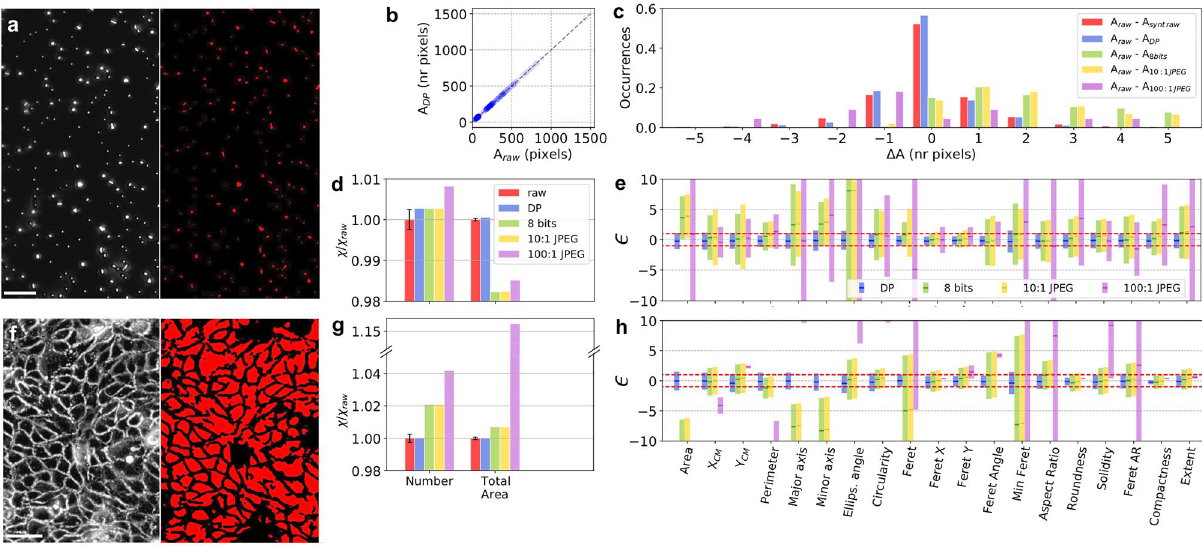
Figure 2. Statistical distortions induced by compression in 2D segmentation tasks in PC microscopy. ( a ) Micrograph of microspheres (scale bar: 20 μm) with corresponding segmentation mask. ( b ) Area of each segmented object obtained from the raw (A raw ) and the corresponding 6.7:1 DP compressed image (A DP ) for all objects. c Histogram of the difference in the single object area (∆A) determined from the raw and the statistically raw-equivalent images (A raw –A synt raw ), the DP (A raw –A DP ), the 8-bit (A raw –A 8bit ), the 10:1 JPEG (A raw –A 10:1 JPEG ) and the 100:1 JPEG file (A raw –A 100:1 JPEG ). ( d ) Values of the parameters associated to the whole segmented image, such as number of objects and total segmented area, obtained from the DP, the 8-bit and the JPEG segmented images and normalized to the raw value. The error bars on the raw values are calculated from the standard deviation of the values obtained from the synthetic raw images. ( e ) Average of the standard score ǫ of 19 parameters associated to the single segmented objects. Red dotted lines correspond to ε = ± 1. ( f ) PC Micrograph of MPK cells (scale bar: 50 μm) with segmentation mask, down-sampled to 8-bits and compressed into 6.1:1 DP, 10:1 and 100:1 JPEG formats. ( g , h ) Same as ( d , e ) for the MPK cells. The figure has been generated